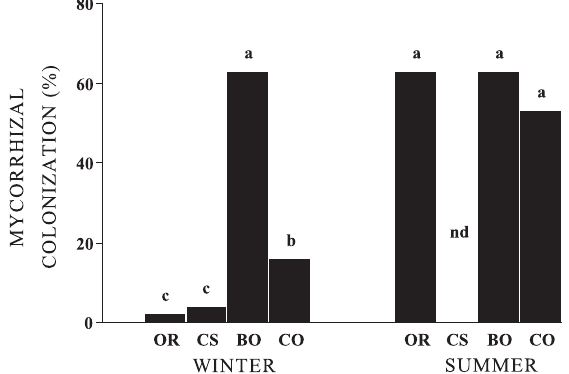
Figure 1. Mycorrhizal colonization indexes in roots collected in plots grown with oilseed radish (OR), corn spurry (CS), black oat (BO) or under fallow (CO) during winter cover crop growth and in the subsequent summer (pearl millet and sunnhemp). (Means followed by the same letter do not differ significantly according to Tukey’s test p ≤≤≤≤≤ 0.05). nd =